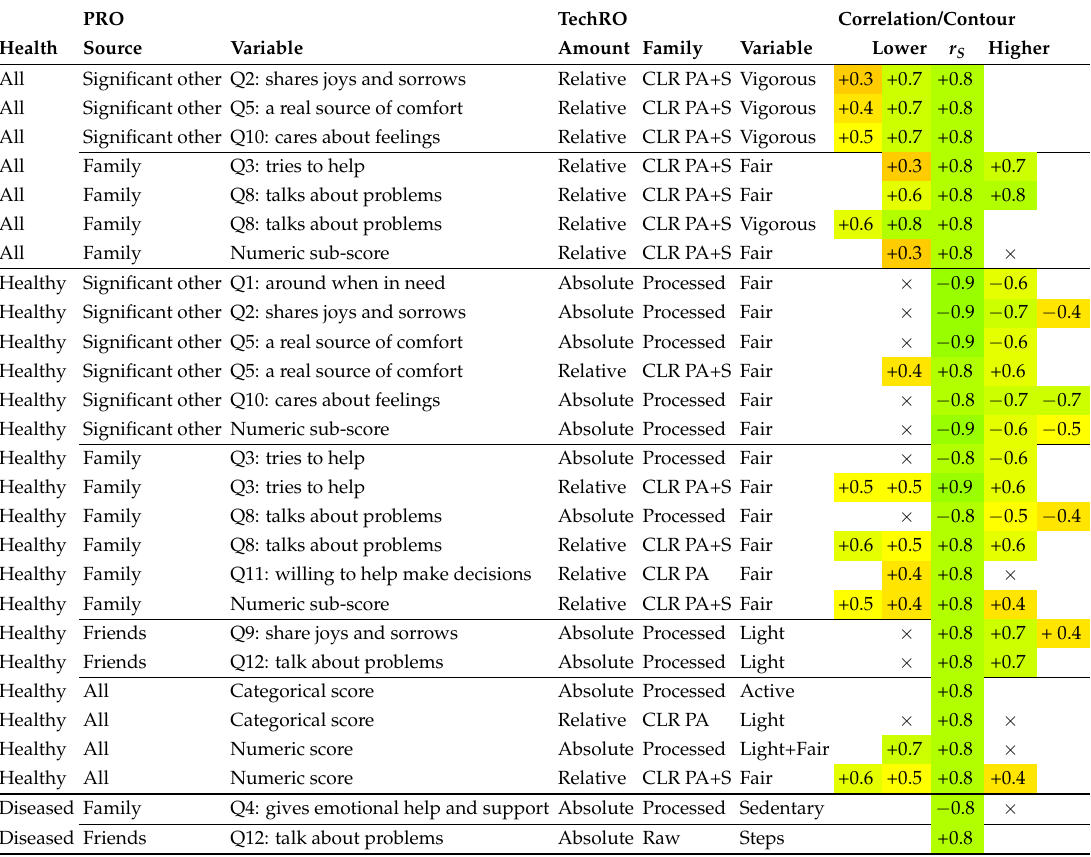
Table 8. Summary of found strong and significant Spearman rank correlations ( r S of social support (MSPSS scale) and TechROs (Fitbit